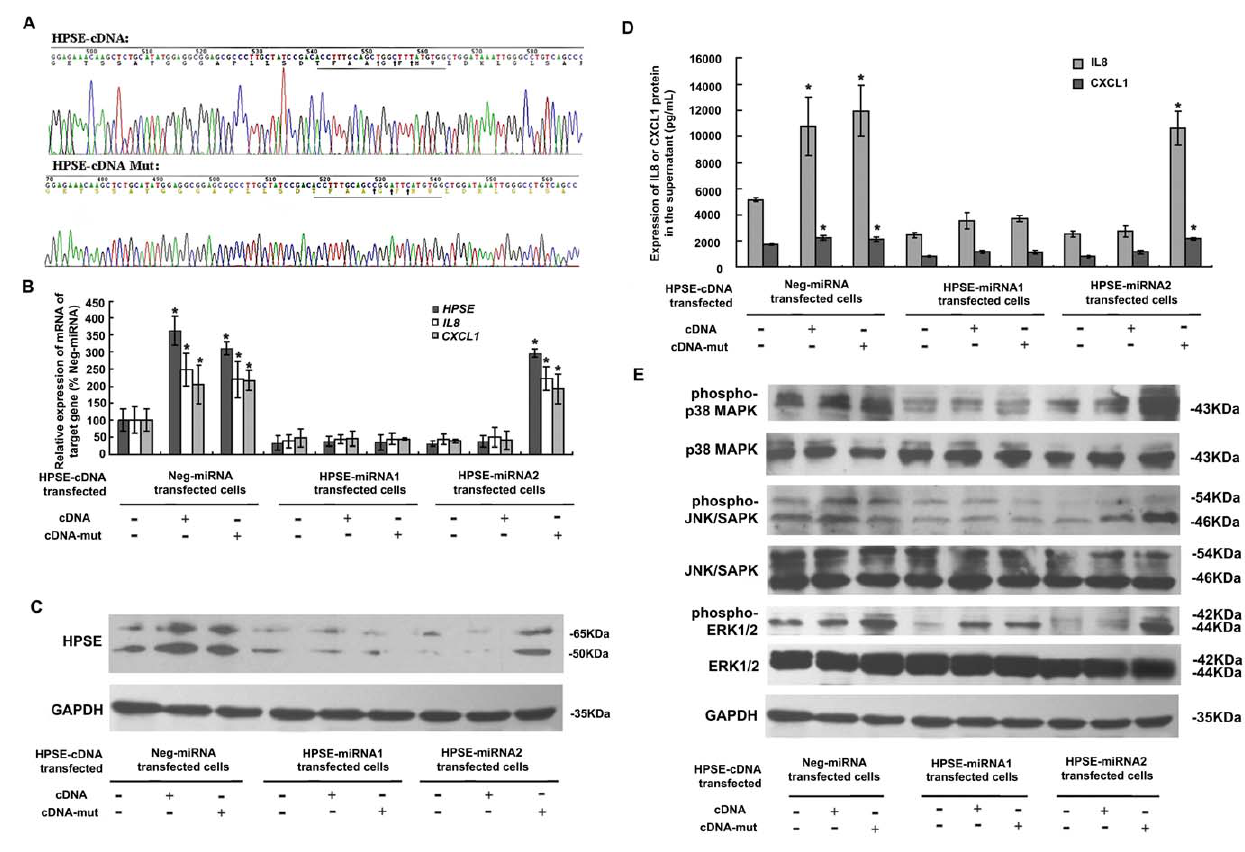
Figure 5. Restoration of HPSE functionality by HPSE RNAi rescue. (A) The sequencing results of the wild type and multisite mutant HPSE cDNA. Three nucleotide substitutions were introduced into the HPSE-miRNA2 hybridizing sequence (5 9 -CCTTTGCAGCTGGCTTTATGT-3 9 ), which was verified by sequencing. (B-D) The levels of both HPSE mRNA and protein were restored in cells of the HPSE-miRNA2 group transfected with mutant HPSE cDNA, similar to those of Neg-miRNA cells transfected with the wild type or mutant HPSE cDNA. Furthermore, mutant cDNA transfection for miRNA rescue also increased IL8 and CXCL1 mRNA and protein levels. However, in HPSE-miRNA1 stably transfected cells, neither the wild type HPSE cDNA nor the mutant HPSE cDNA could restore the expressions of HPSE , IL8 and CXCL1 . (* P , 0.05 compared with the respective non-cotransfected cells). (E) Restoration of the HPSE-induced phosphorylation of MAPKs in the cells of the HPSE-miRNA2 group by mutant HPSE cDNA. Phosphorylation of MAPK p38 (first and second panel), JNK/SAPK (third and fourth panel), and ERK1/2 (fifth and sixth panel) was monitored by western